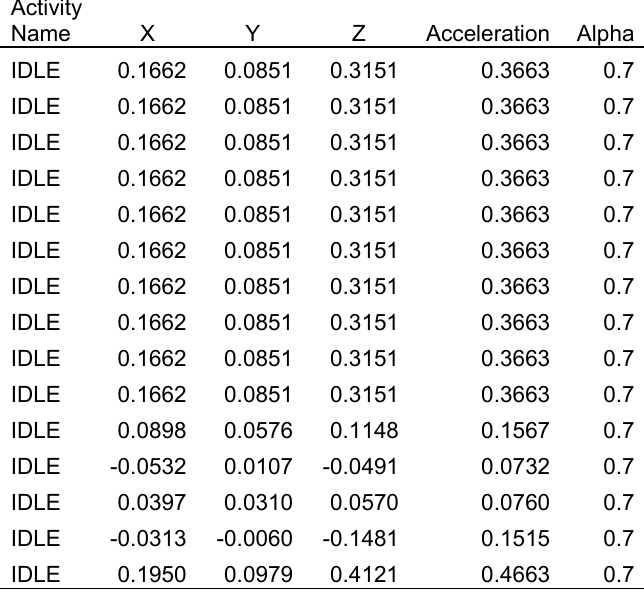
Table 3. Acceleration in Idle Case with